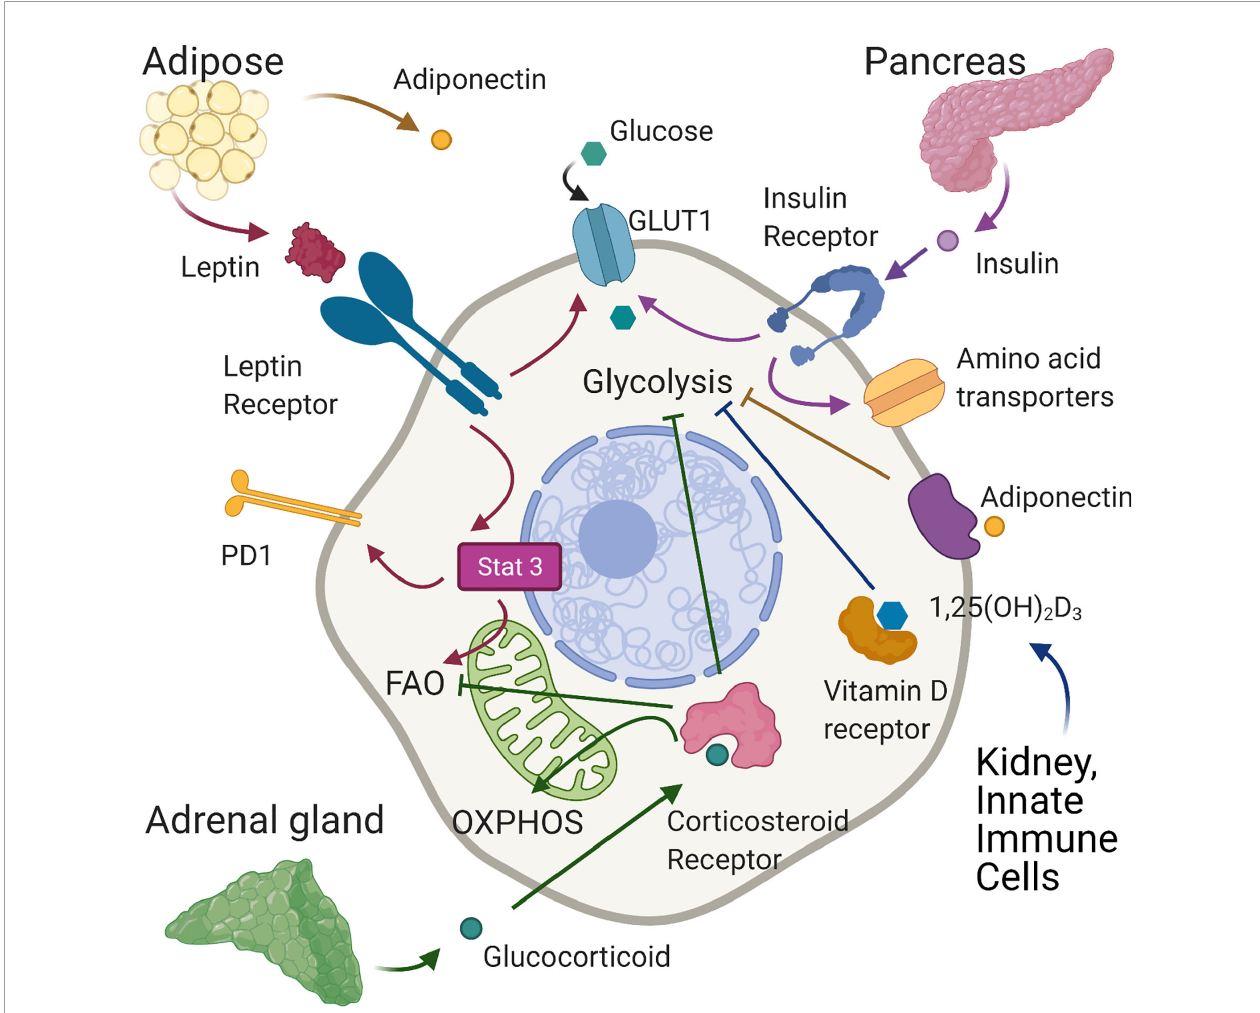
FIGURE 2 | Effects of hormones on T cell metabolism. In normal conditions leptin, produced mainly by adipose tissue, binds the leptin receptor on T cells, upregulating GLUT 1 expression on CD4+T cells enabling the shift towards glycolysis required for effector function. In tumour models of diet-induced obese mice, leptin signaling induced-phosphorylation of STAT3 upregulates PD1 expression and FAO in tumour-in fi ltrating CD8+ T cells leading to decreased CD8 effector T cell function and tumour progression. Adiponectin, also produced largely by adipose tissue, is able to inhibit glycolysis and T cell in fl ammatory activity in CD4+ cells. Insulin, secreted by pancreatic islets, binds insulin receptors expressed on activated T cells increasing glycolysis and the expression of amino-acid transporters. Corticosteroids, released by the adrenal gland, can suppress glycolysis and increase OXPHOS. In tumour immunity, corticosteroid sensitive, low af fi nity CD8 T cells are inhibited by corticosteroids through impairment of fatty acid oxidation. Vitamin D, generated in the skin and then activated mainly in the liver and kidneys may reduce in fl ammation by suppressing glycolysis in T cells. Created with